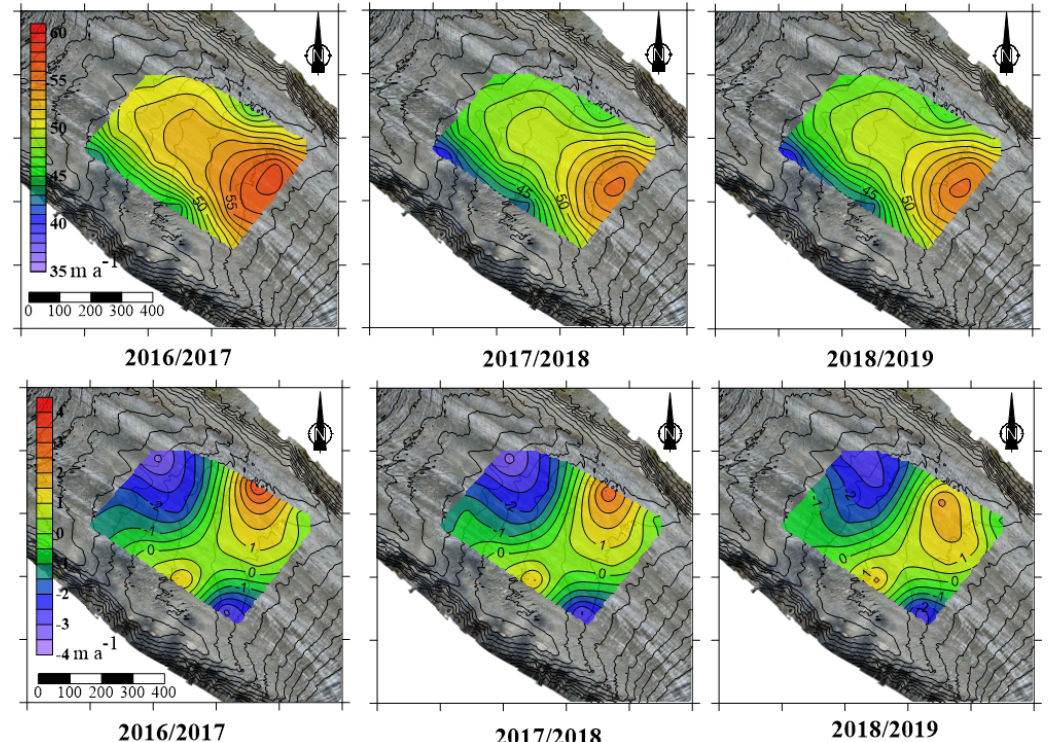
Figure 4. Horizontal (top panels) and vertical (bottom panels) ice flow velocities (ma − 1 ) measured over 3 years from the ablation stakes. Note the different colour scales. Distances in metres.